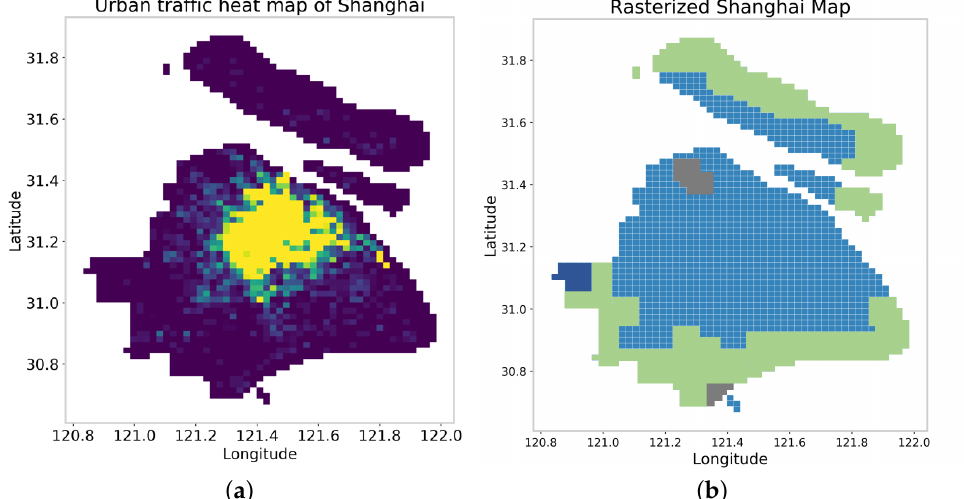
Figure 3. ( a ) Urban traffic heat map of Shanghai. ( b ) Rasterized Shanghai